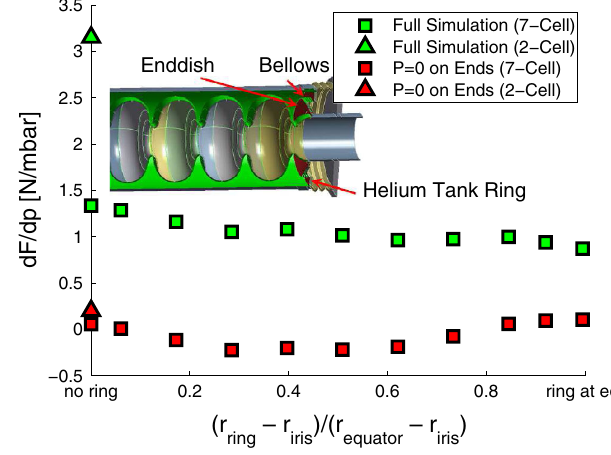
FIG. 10. K of the two cavity assemblies, with data from both a simulation of the full model and from simulations of individual parts, put together using the equations in Fig. 9.